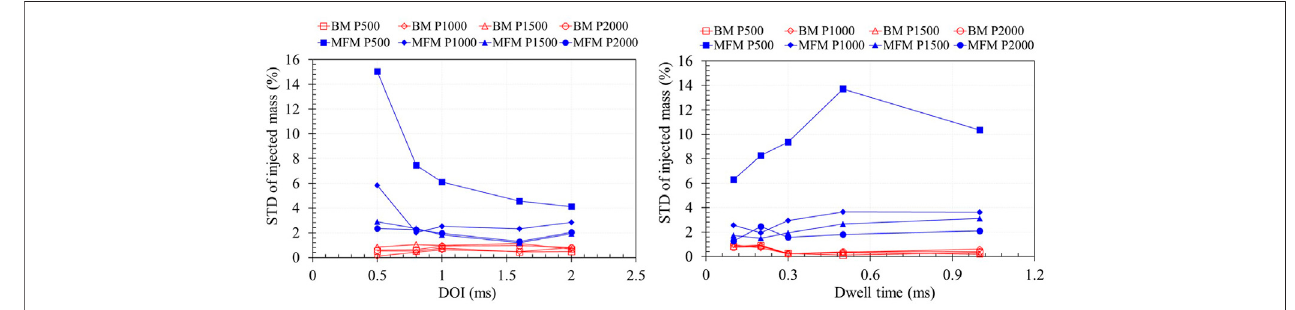
FIGURE 3 | Comparison of the cyclic variabilities of BM and MFM observed at different injection pressures, DOI, and Dwell times for the split injection tests.